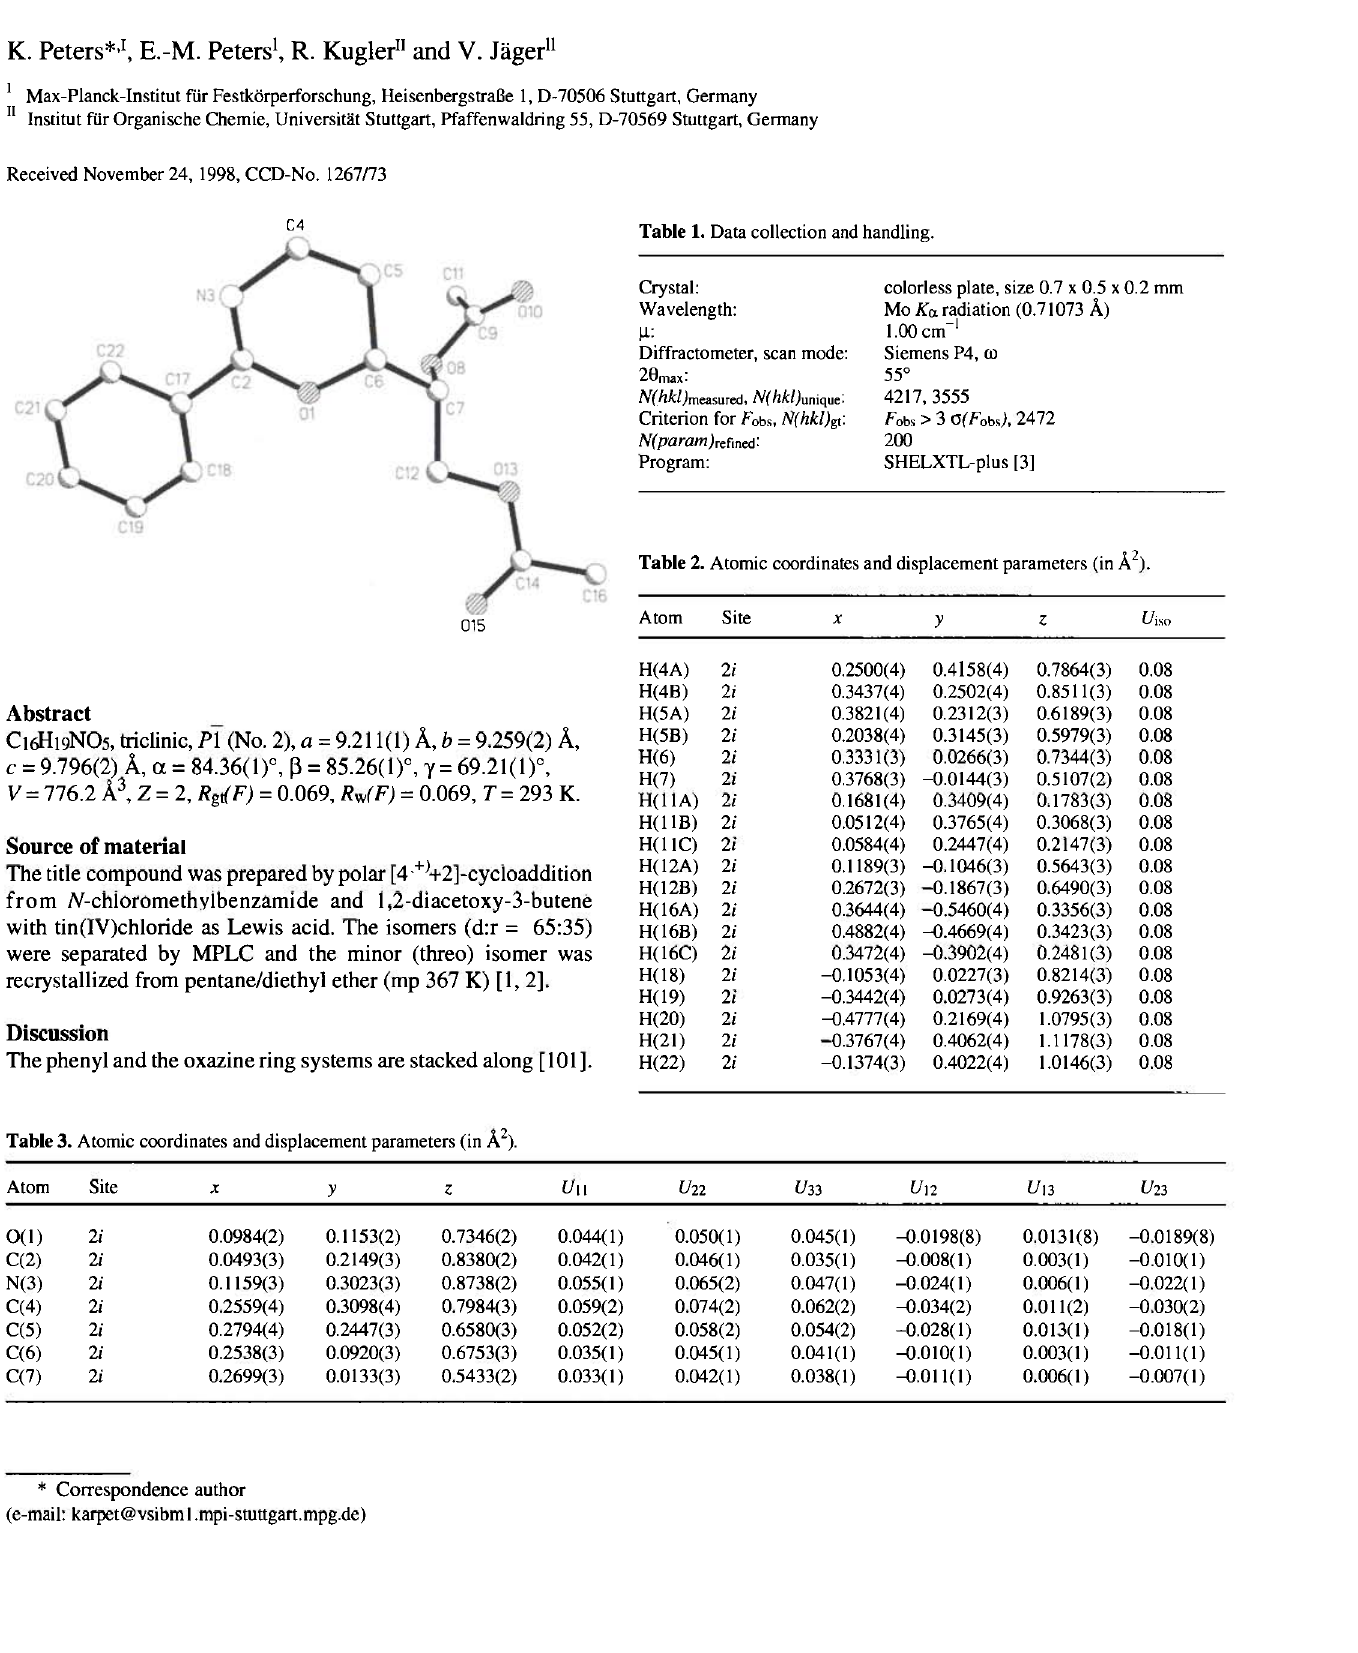
Table 1. Data collection and handling.